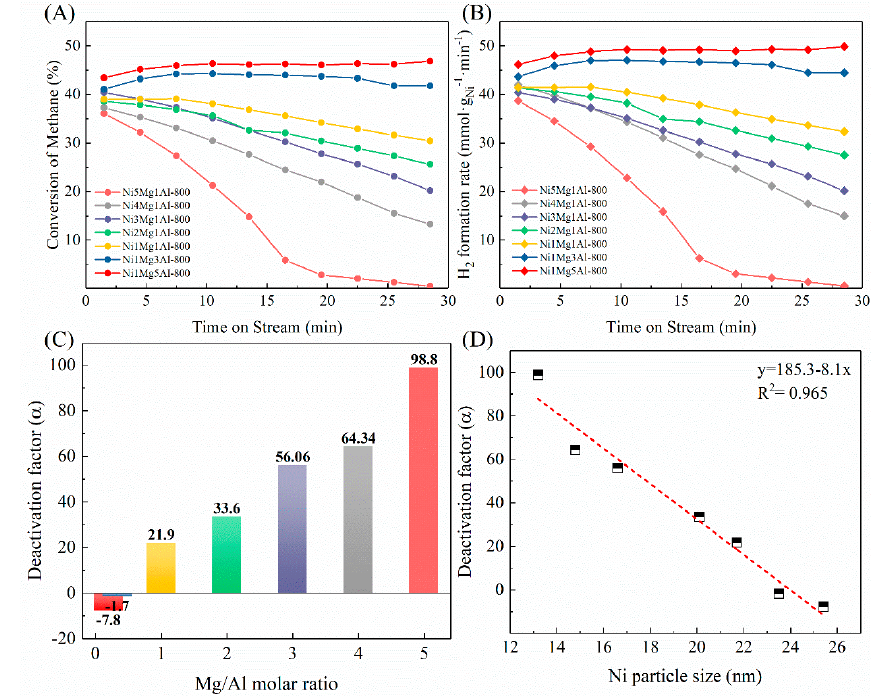
Figure 5. ( A ) Methane conversion ( x CH 4 ) and ( B ) hydrogen formation rate ( R H 2 ) versus the reaction time over the Ni x Mg y Al-800 catalysts, ( C ) deactivation factors of each Ni x Mg y Al-800 catalyst, ( D ) deactivation factor as function of nickel particle size. Reaction conditions: 99.99% CH 4 , total flow = 30 mL / min, catalyst loading = 0.2 g, reaction temperature: 650 ◦